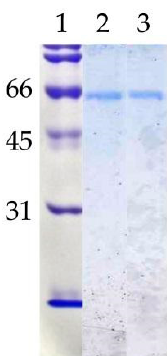
Figure 2. Polyacrylamide gel electrophoresis (SDS-PAGE). Lane 1: Molecular weight standards (kDa); lane 2: mLip 3 (1 μ g); lane 3: dLip3 (1 μ g). 15% acrylamide gel, Coomassie Blue staining.